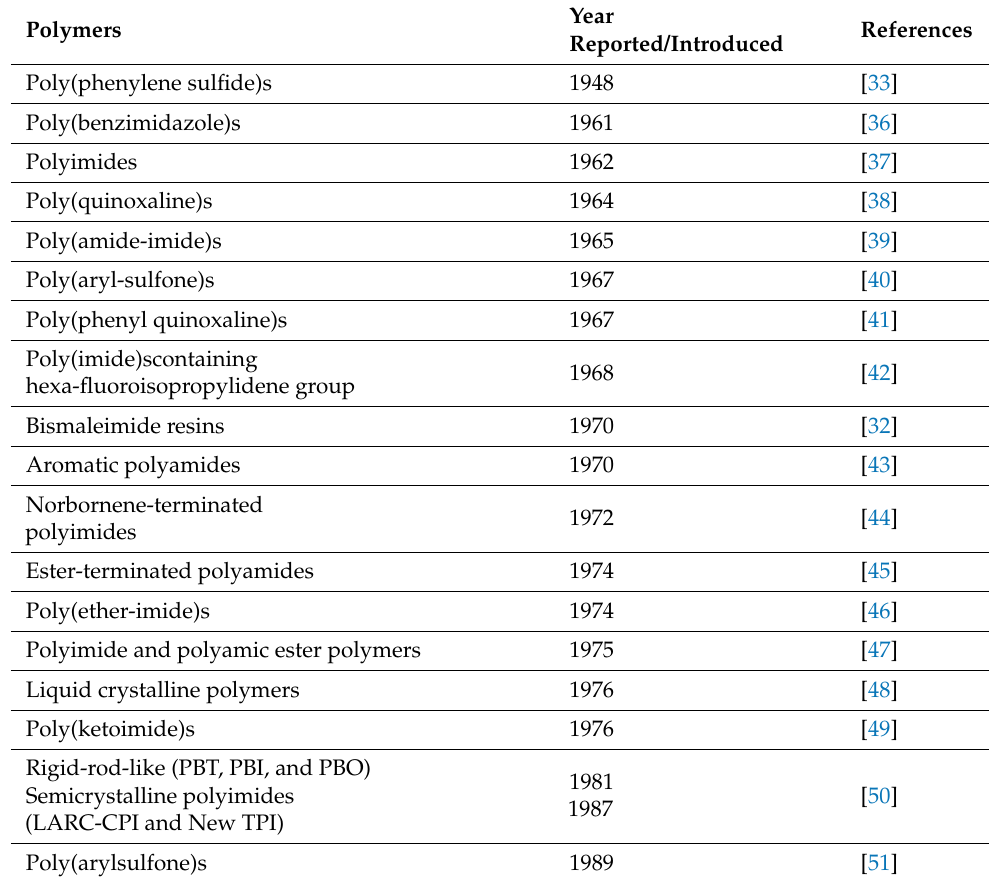
Table 1. List of high-performance polymers (HPPs) along with their year of reporting/commencement.